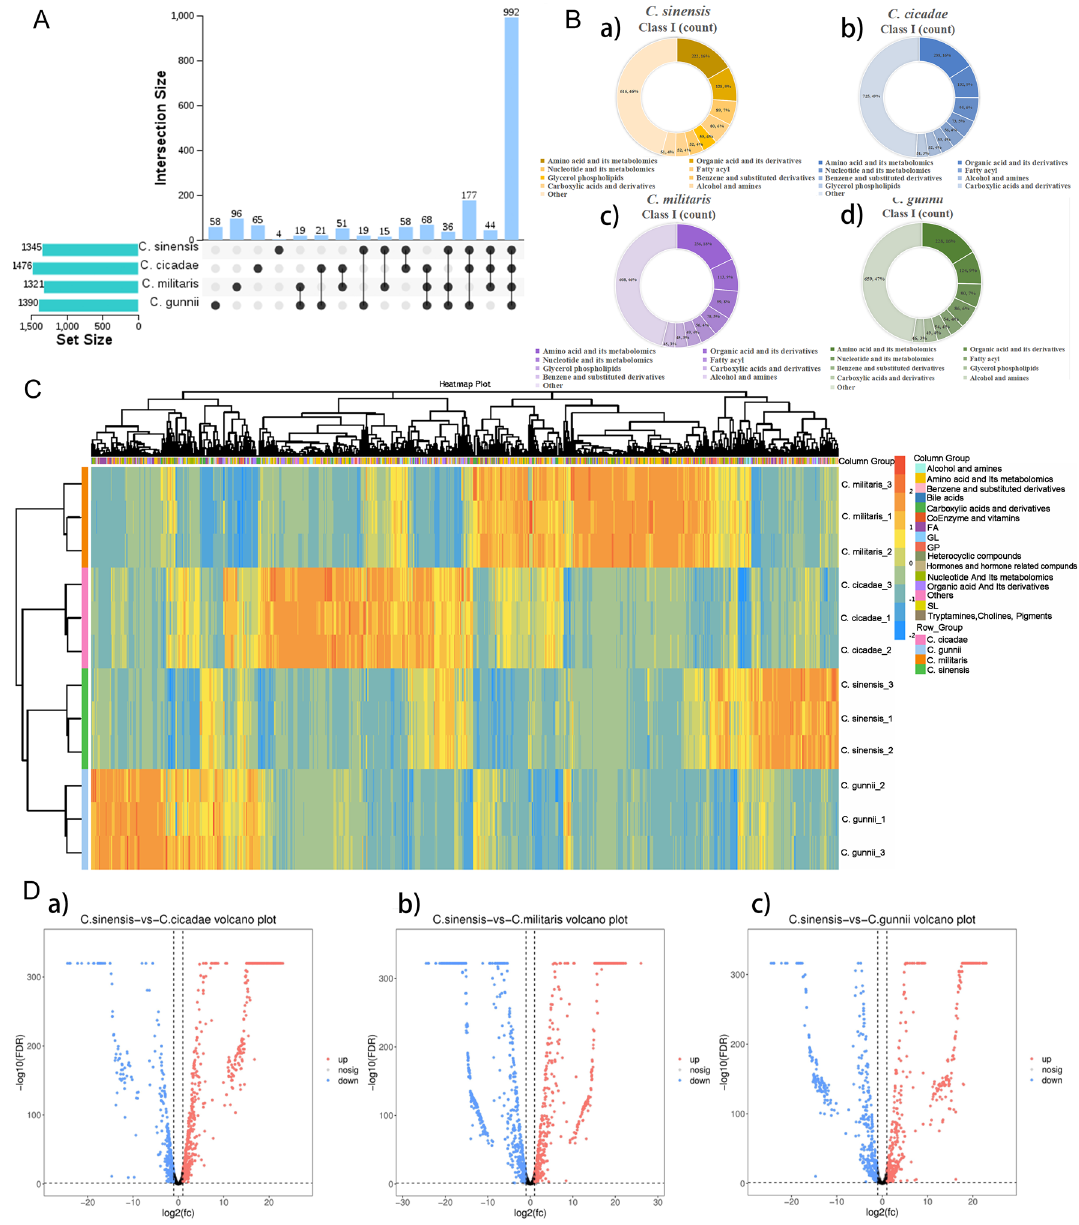
Figure 4. Analysis of total metabolites in C. sinensis, C. cicadae, C. militaris and C. gunnii . ( A ) UpSet venn diagram for the total difference of metabolites between C. sinensis, C. cicadae, C. militaris and C. gunnii . ( B ) Pie chart of grouping proportion of total metabolites in the samples of C. sinensis (a) , C. cicadae (b), C. militaris (c) , C. gunnii (d). ( C ) Cluster heat map of total metabolites in the samples of C. sinensis, C. cicadae, C. militaris and C. gunnii . ( D ) Volcanic map of total different metabolites between C. sinensis and C. cicadae (a), C. militaris (b), C. gunnii